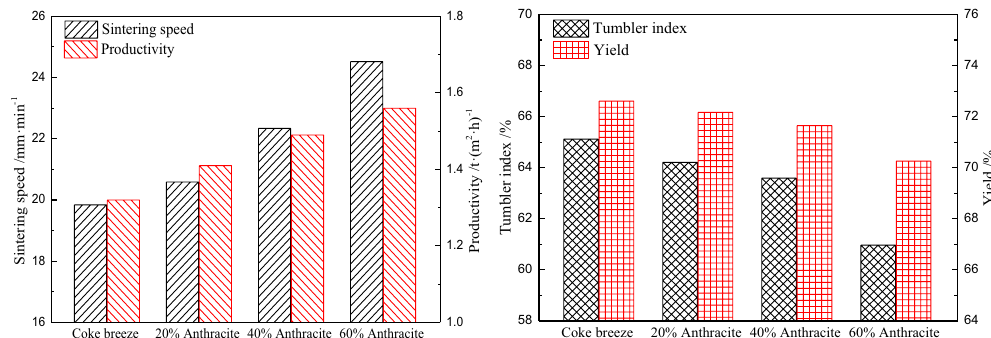
Figure 6. Effect of substituting anthracite for coke breeze on the sintering indexes.